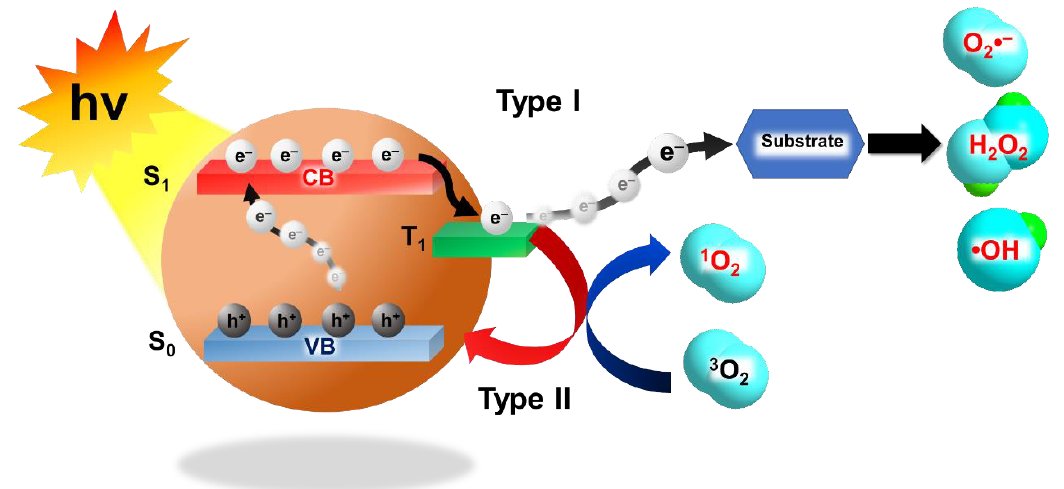
Figure 1. Schematic illustration of Type I photodynamic therapy (PDT) and Type II PDT. (hv: photon energy; CB: conduction band; VB: valence band).